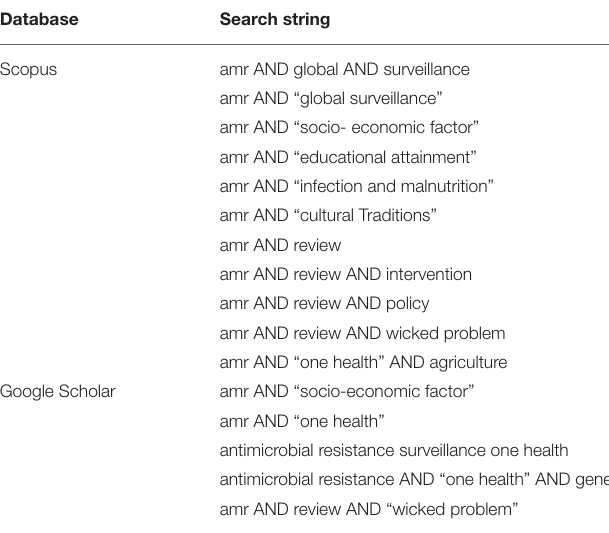
TABLE 1 | Literature research to identify the drivers that influence antimicrobial resistance